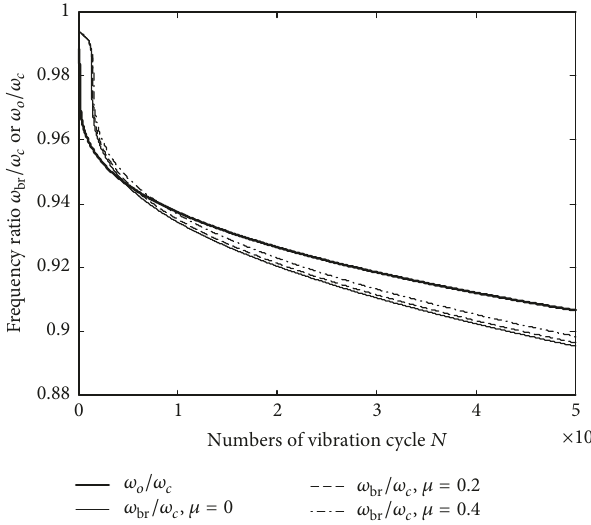
Figure 15: Frequency ratio with vibration cycles ( 𝜔/𝜔 𝑐 = 0.98 ).